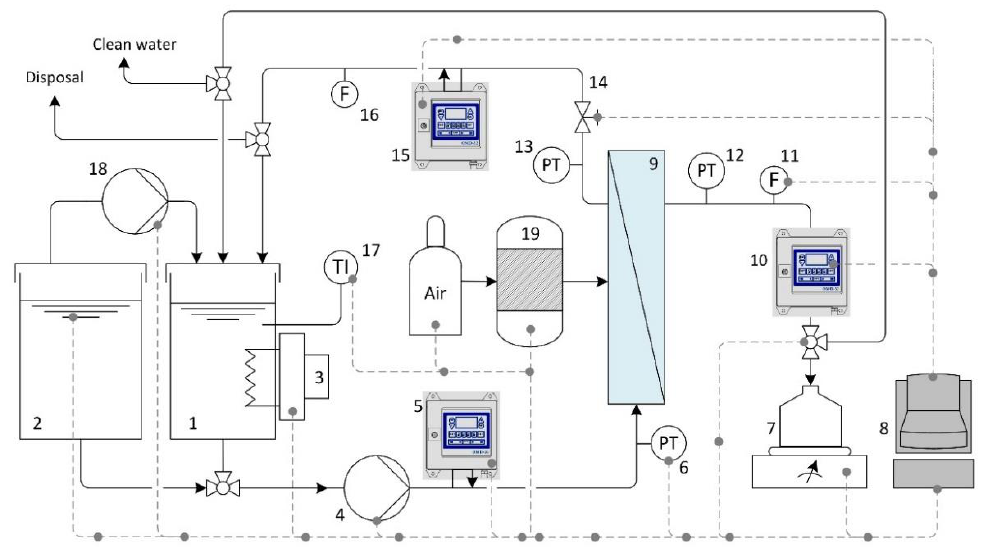
Figure 5. Schematic representation of the semi-automatic crossflow filtration unit: (1 + 2) feed tanks; (3) heading element; (4 + 18) pumps; (5 + 10 + 15) oil-in-water sensors; (6 + 12 + 13) pressure transducers; (7) balance; (8) automation and process control system; (9) ceramic membrane module; (11 + 16 + 20) flow meters; (14) valve; (17) temperature transducer; (19) back flush tank.